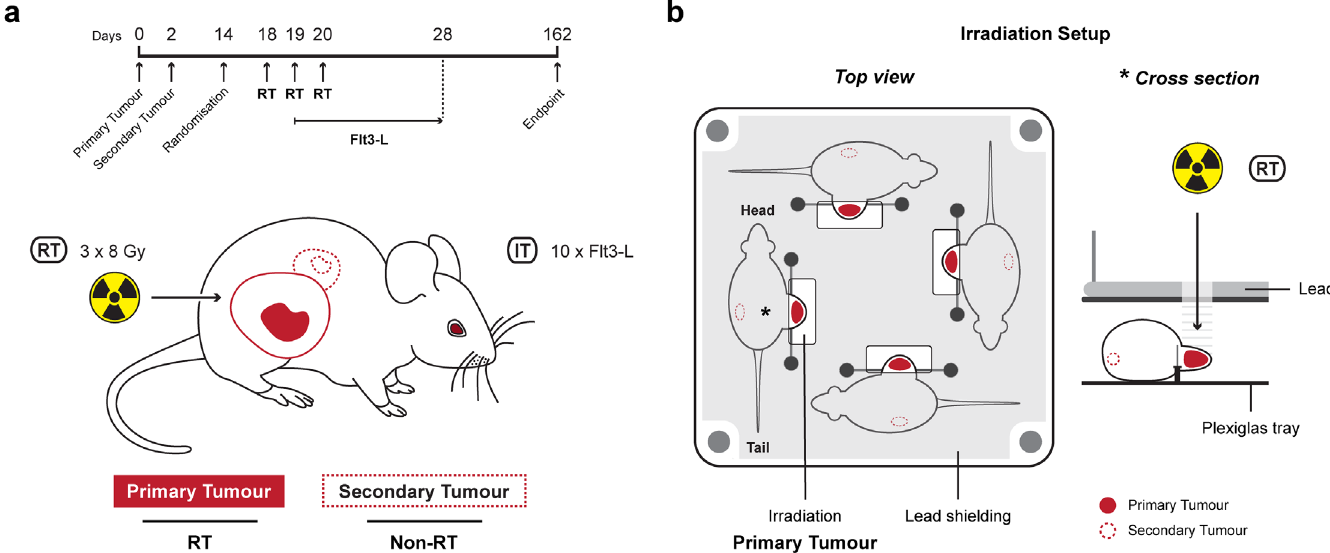
Fig 1. Mouse model to investigate the abscopal effect. a. Schematic representation of the 67NR mammary carcinoma Balb/C mouse model and the timeline of treatments. 1 * 10 5 67NR tumour cells were inoculated in the right (primary, straight line) and left (secondary, dashed line) flank on day 0 and 2, respectively. At day 14, animals were randomised based on the primary tumour size and assigned to four groups (untreated, Flt3-L, RT, RT+Flt3-L). Fractionated radiotherapy (RT, 3 x 8 Gy) was only given to the primary tumour at day 18, 19, and 20. Immunotherapy (IT, DC growth factor Flt3-L) was administered for ten consecutive days, started at day 19. The endpoint was at day 162 or a total tumour volume of 2cm 3 . b. Schematic representation of the irradiation setup. Four tumour-bearing mice (per session) were positioned in a customized Plexiglas tray. The animals ’ body was protected by lead shielding except for the primary tumour that was placed under a linear accelerator. The star ( * ) in the top view indicates the position of the cross section view.